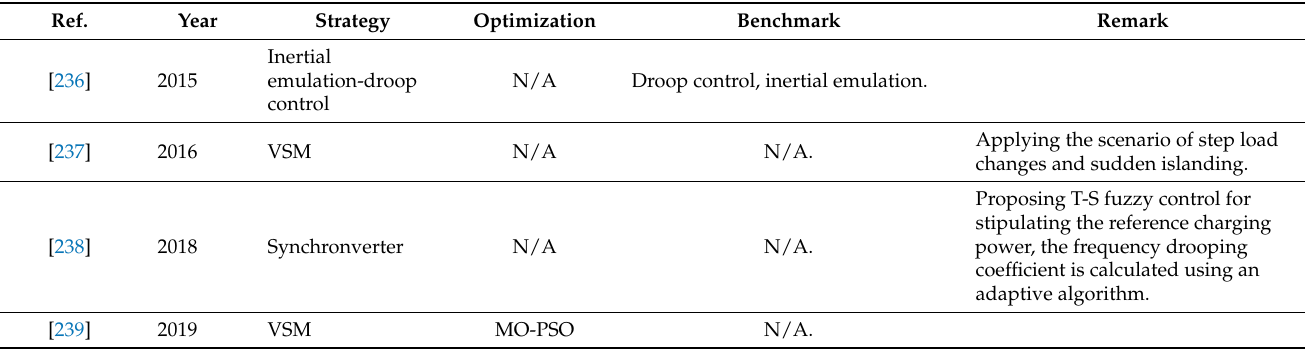
Table 6. EVAS as an inertia